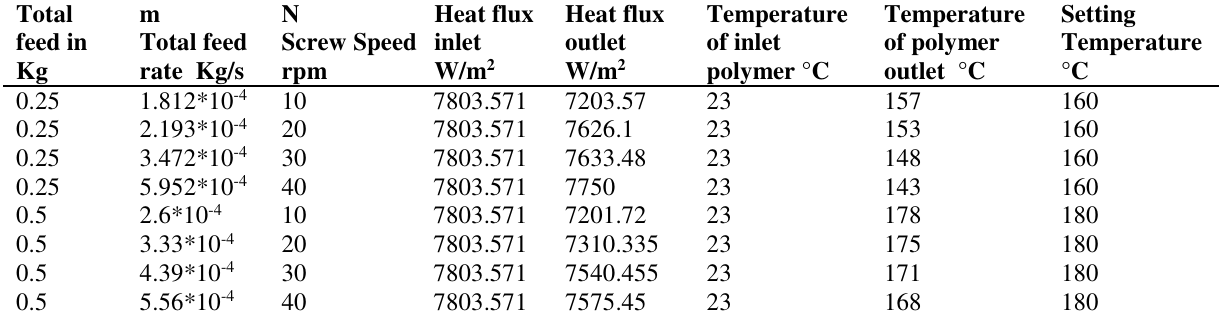
Fig. 3. The thermophysical properties of polypropylene 575 at different temperature . (a)Viscosity. (b) thermal conductivity. (c) Specific heat. (d) Density. Overall data for the practical part of single screw